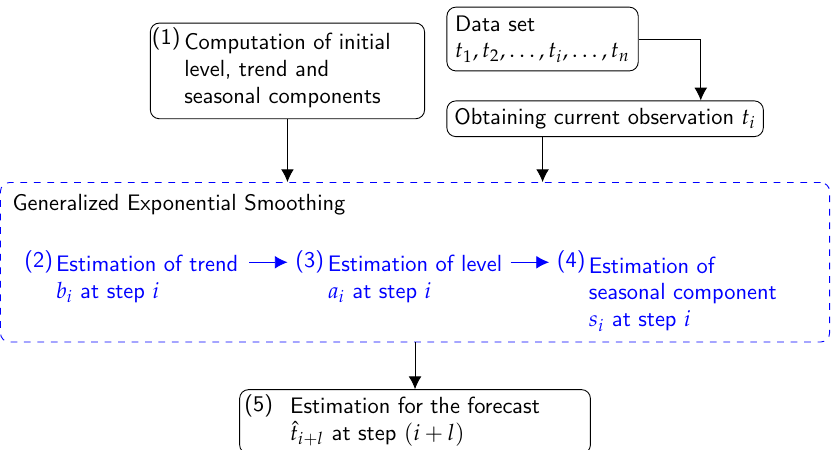
Figure 6. The flow diagram displays five steps for carrying out the additive SH-W method. Step (1) indicates that the initial conditions for the components are computed. Steps (2), (3), and (4), indicate that the slope, level and seasonal component at step i are estimated. Finally, step (5) indicates that forecasts (ˆ t i + l ) at step ( i + l ) are calculated, where l : 1,. . .,24. According to this method, the level, trend, and seasonal components are updated over a historical 521 period. For example, when the method is applied per month, the components are updated every 522 hour over each month. If the algorithm converges, a , b and s 1 to s 24 are the estimated values for 523 the level, trend and seasonal components at the last instant of time in the month. 524